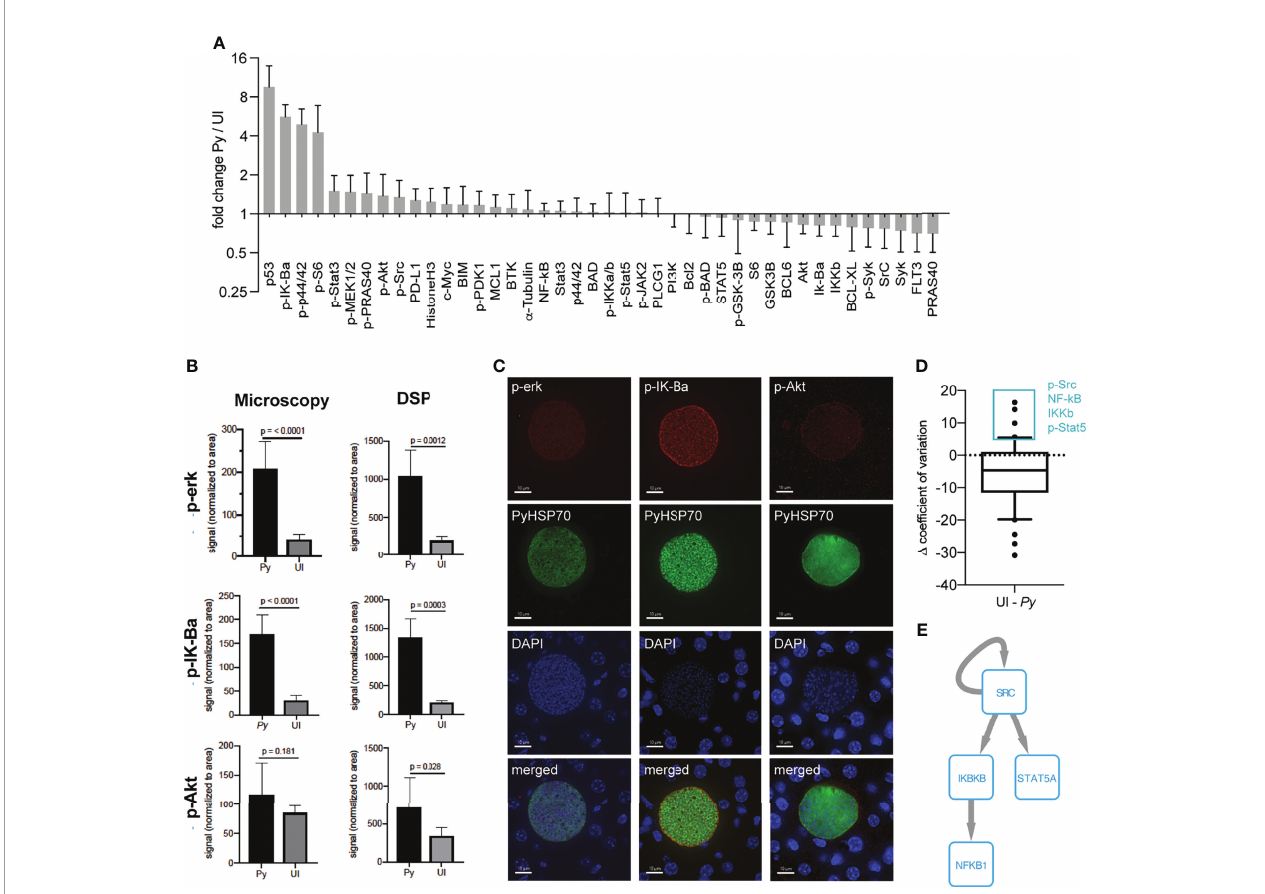
FIGURE 2 | Single infected hepatocytes produce suf fi cient signal for detection by DSP. (A) Signal from 9 infected cells from a single P. yoelii -infected mouse normalized to region of interest (ROI) area and to the average signal from 6 uninfected cell regions from a single uninfected mouse. Error bars indicate standard deviation. (B) ROI-area-normalized signal from single infected and uninfected ROIs as measured by DSP (from panel A ) and single antibody staining fl uorescent microscopy (n = 6 ROIs each from a single infected or uninfected mouse). (C) Representative images of infected cells were taken at a total magni fi cation of 400x at 44hpi. (D) Difference in coef fi cient of variation between uninfected and single infected ROIs (from panel A ) for each antibody. Box plot encompasses 10 th -90 th percentile. Antibodies within the 90 th percentile which showed less variation in infected ( Py ) than in uninfected ROIs are boxed in blue. (E) Phosphosignaling network constructed from proteins with lower variation in infected ROIs. Arrows indicate direct phosphorylation